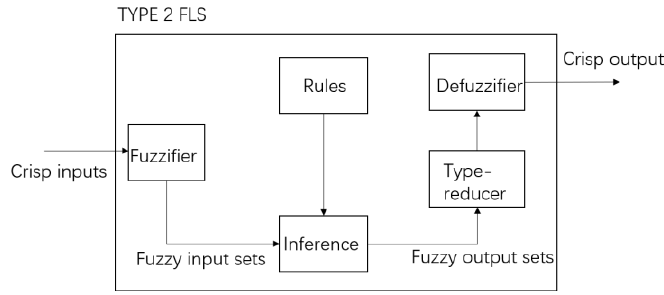
Figure 2. Type-2 fuzzy set in a two-dimensional plane.